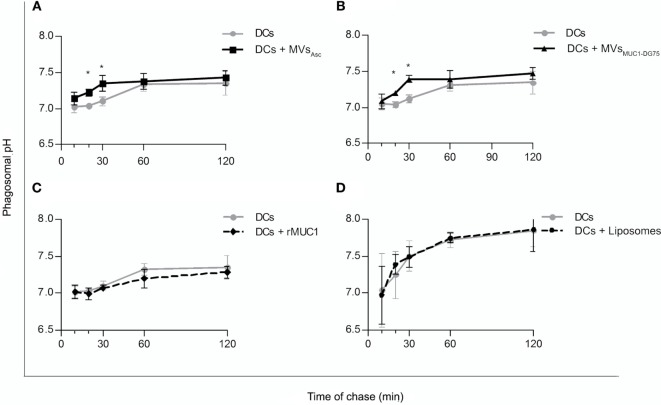
Increase of dendritic cell (DC) phagosomal pH following internalization of tumor-derived MVs. Time course experiments to evaluate the phagosomal pH values in unpulsed DCs (gray line) and DCs pulsed with MVsAsc
(A), MVsMUC1-DG75
(B), recombinant MUC1 glycoprotein (rMUC1) (C), and Liposomes (D) (black line). Each graph shows the average and SD of independent experiments. DC phagosomal pH significantly increased (*p < 0.05) when DCs were pulsed with MVs purified from ovarian cancer ascites fluid [(A), five independent experiments] or shed by DG75 cell line [(B), three independent experiments] (*p < 0.05 at 20 and 30 min). No change in phagosomal pH was observed when rMUC1 glycoprotein [(C), 5 independent experiments] or Liposomes [(D), four independent experiments] were used to pulse DCs.